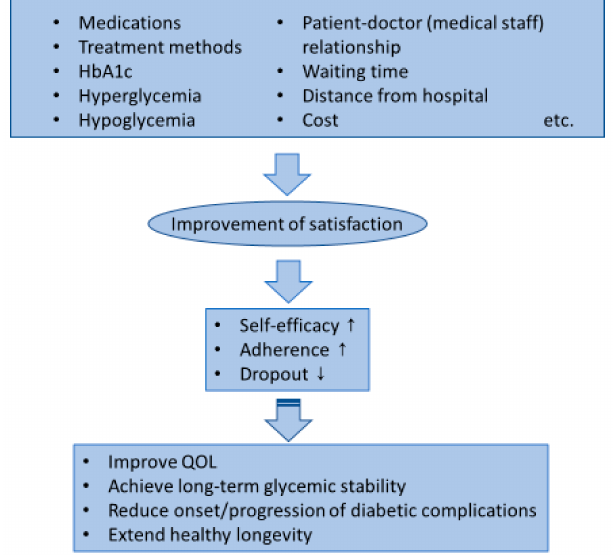
Figure 1. Factors associated with treatment satisfaction and expected effects from its improvement on clinical